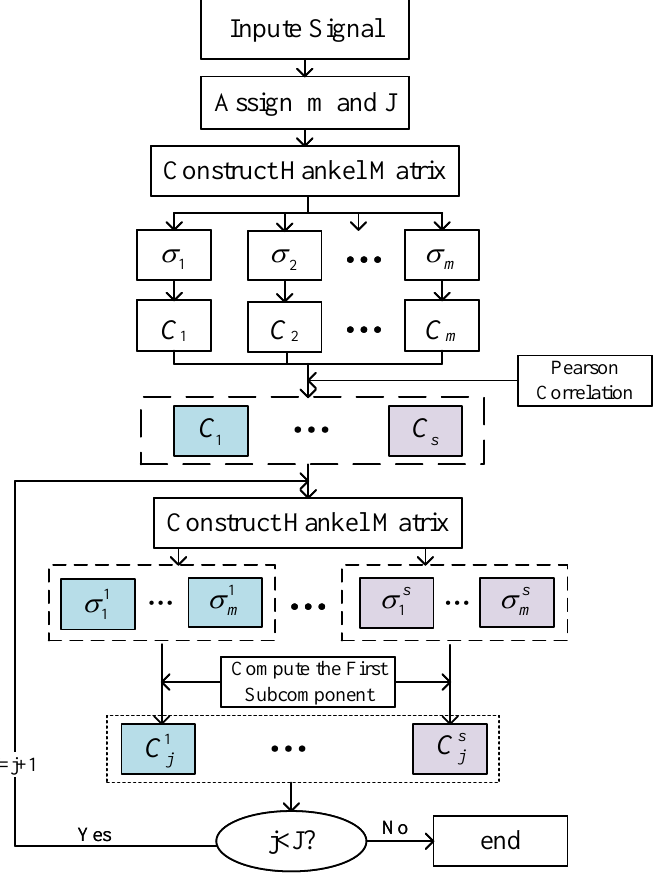
Figure 4. Flowchart of ISVDP on bearing fault